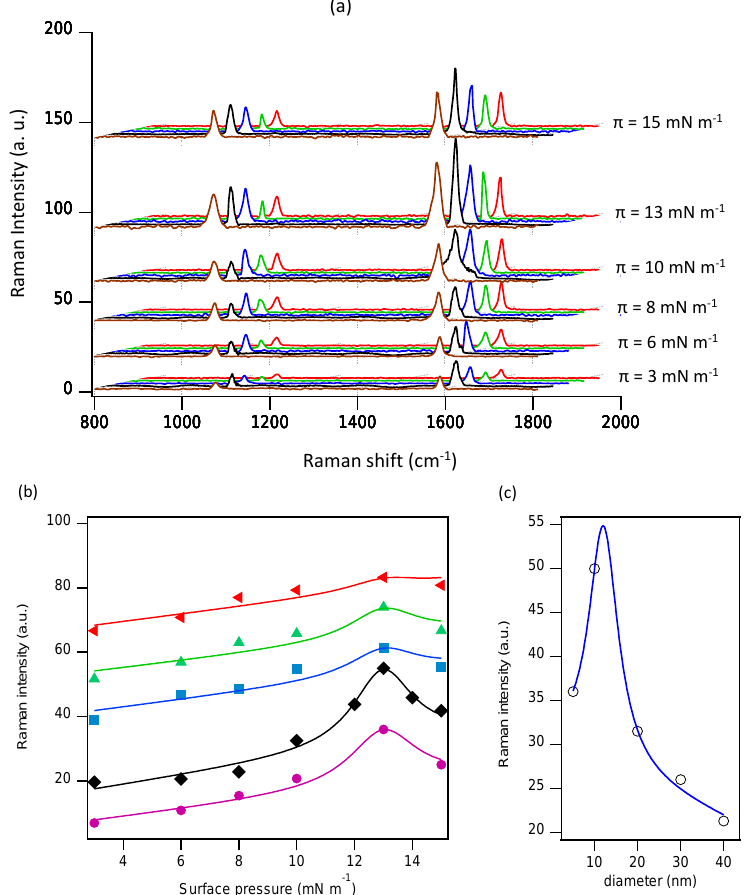
Figure 3. ( a ) Surface Enhanced Raman Spectroscopy (SERS) spectra of 4-MBA adsorbed on gold spherical NP monolayers prepared at different lateral pressures (as indicated in each series) and 8 min of gold electroless plating time. For each series, and from front to back, NP sizes are 5 nm, 10 nm, 20 nm, 30 nm, and 40 nm. ( b ) Height of the SERS peak at 1588 cm − 1 for the data in ( a ). From bottom to top, NP size is ordered as in ( a ). ( c ) Height of the SERS peak at 1588 cm − 1 and a surface pressure of 13 mNm − 1 , as a function of NP size. The lines through data are guides for the